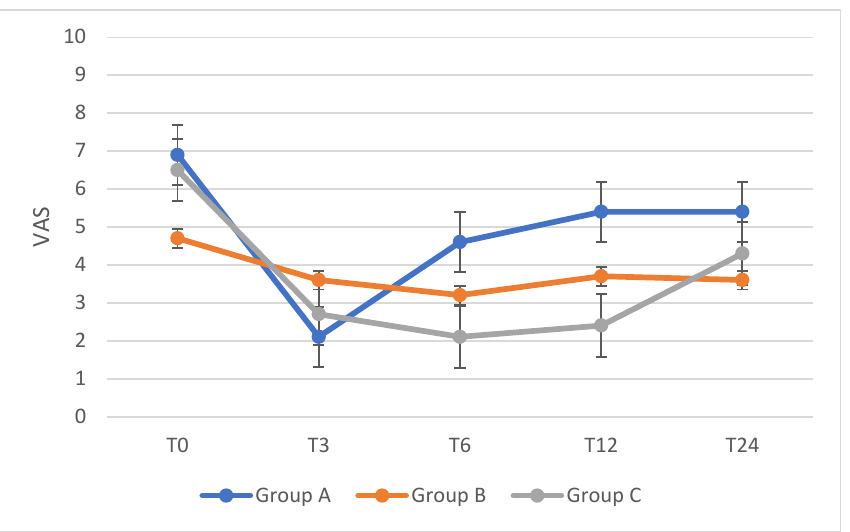
Figure 1. Changes of dysmenorrhea VAS score over time in exclusively breastfeeding women compared to the months of breastfeeding. T0 = before pregnancy; T3 = 3-month follow-up; T6 = 6-month follow-up; T12 = 12-month follow-up; T24 = 24-month follow-up. A = 1–2 months of breastfeeding; B = 3–5 months of breastfeeding; C = 6–8 months of breastfeeding.